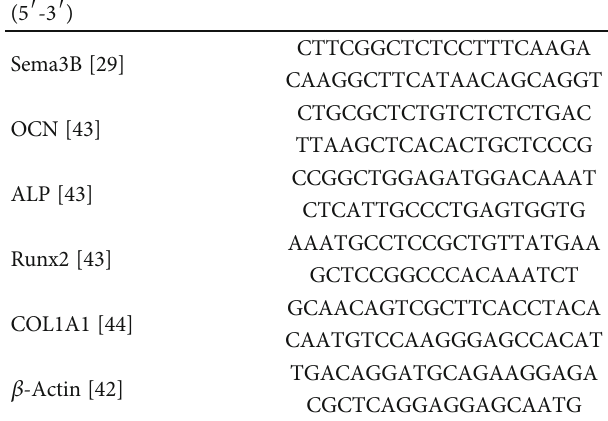
Table 1: Primer sequence used for real-time PCR analysis. Gene forward primer sequence (5 ′ -3 ′ )/reverse primer sequence (5 ′ -3 ′